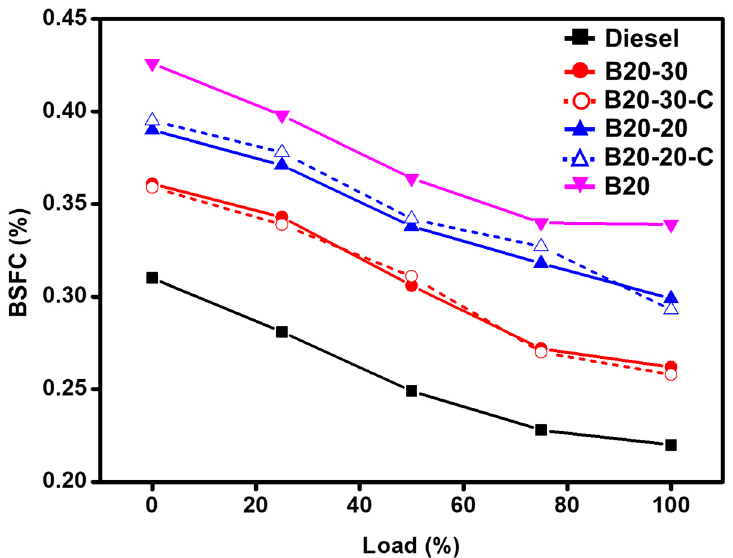
Figure 7. Comparative graphical illustration of brake specific fuel consumption (BSFC) diesel and blends vs. load (%) (with ZnO-GS and ZnO-C). B20 is D-COME, i.e., discarded cooking oil methyl ester, which is blended with 20% commercial diesel; B20-20 is the blend of B20 with 20 mg of ZnO-GS/C; B20-30 is the blend of B20 with 30 mg of ZnO-GS/C.